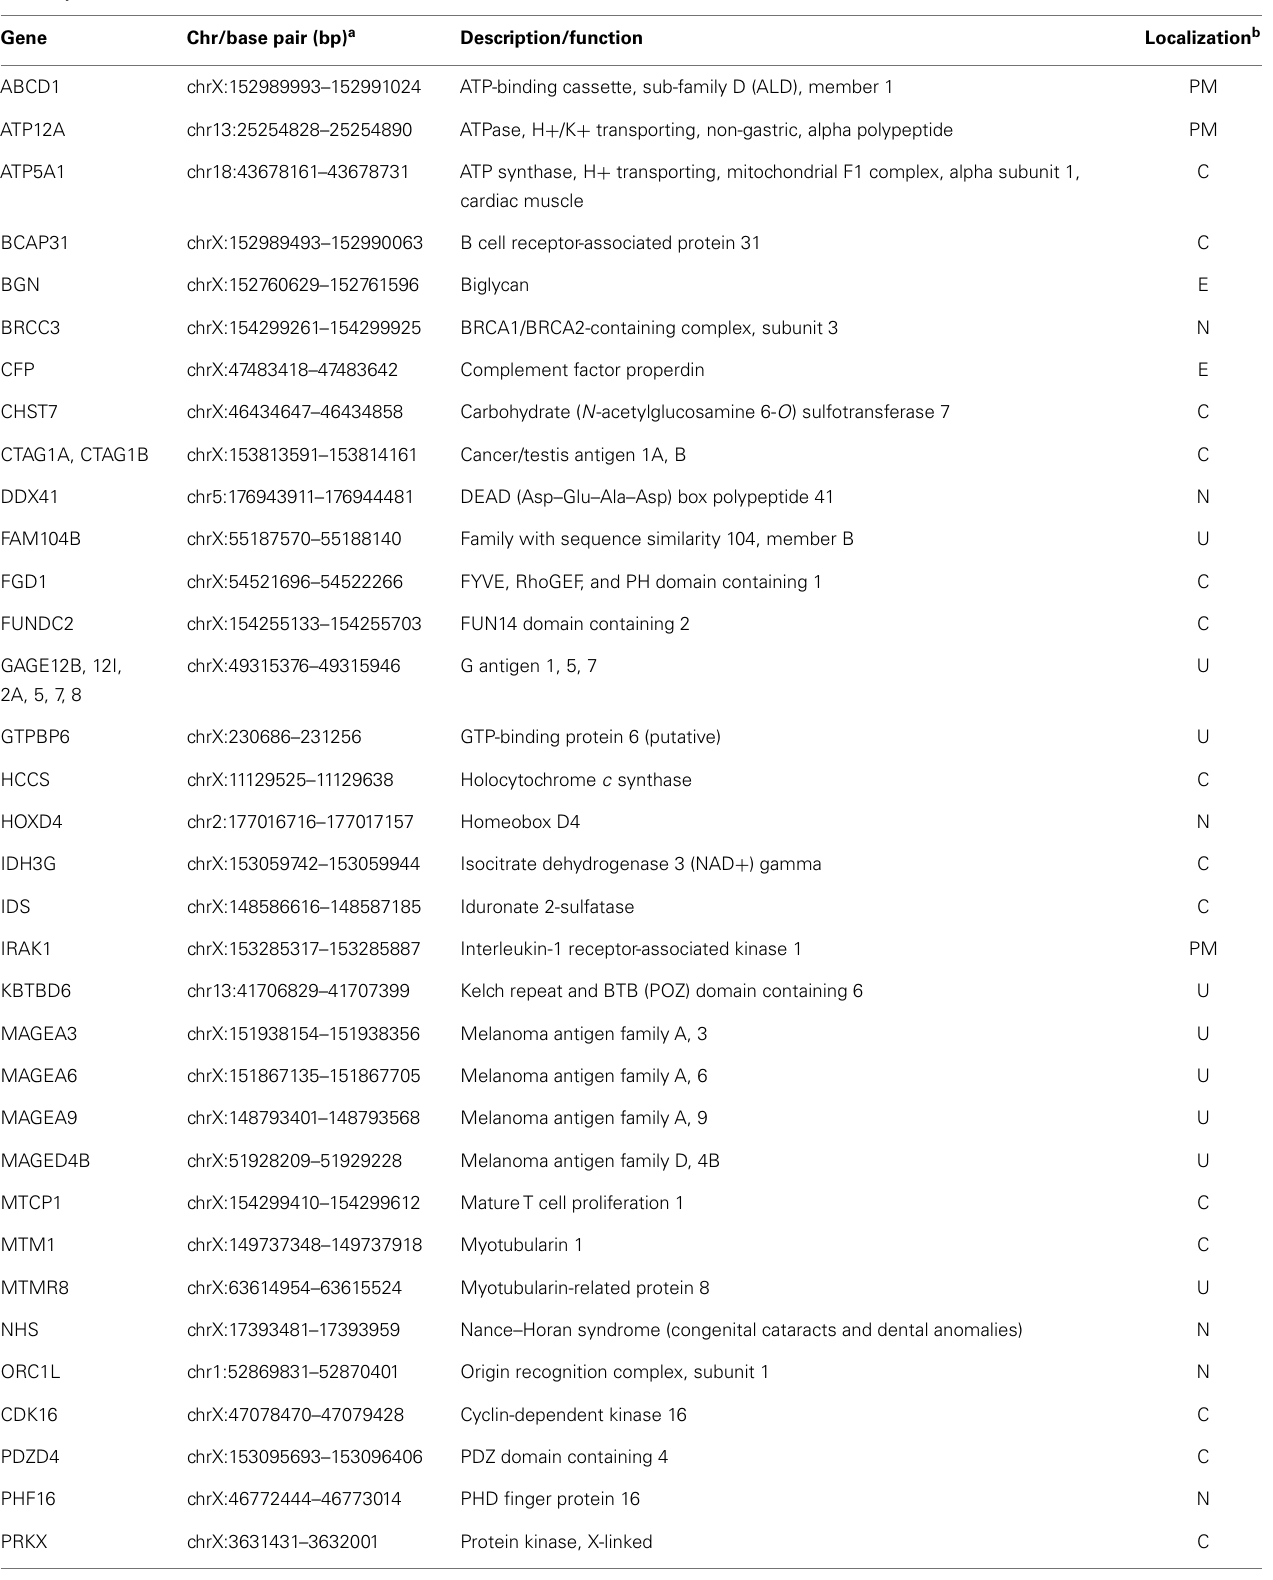
Table 2 | Differentially methylated genes in PBC-discordant MZ twins